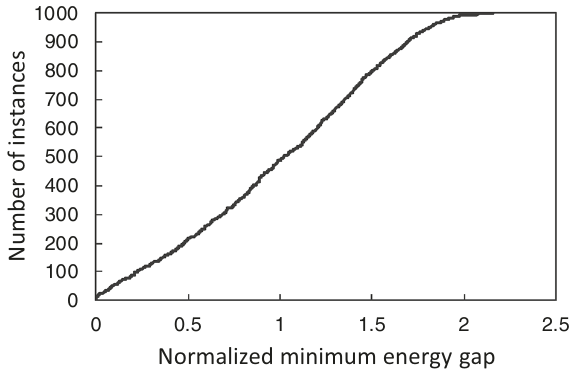
Table 1 Comparison between failure probabilities of ground-